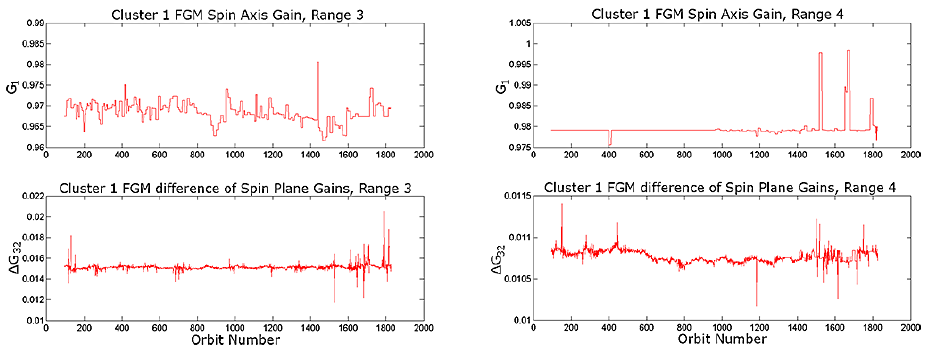
Figure 10. Gain plots ( G 1 and 1G 32 ) from February 2001 to February 2012 for exceptional cases in C1.